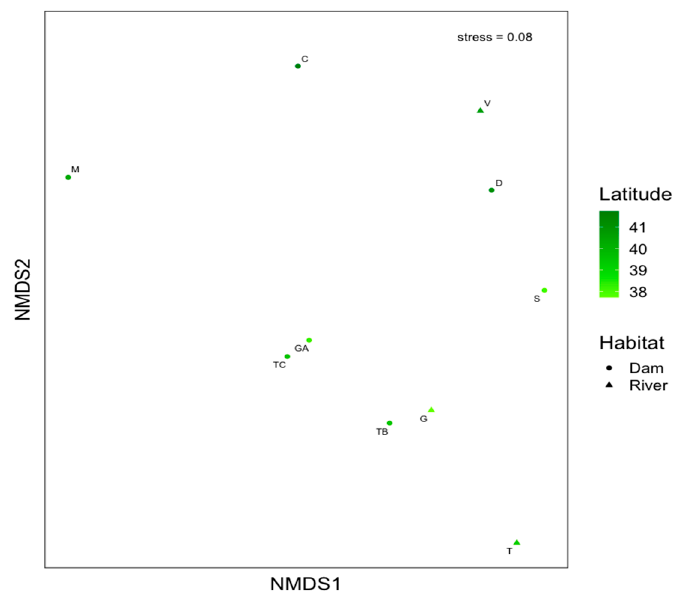
Figure 2. Nonmetric multidimensional scaling (NMDS) ordination of the diet of pikeperch Sander lucioperca populations in Portuguese basins using averaged mean locations (i.e., centroids). Symbols for sites are shaded by latitude from north (dark) to south (lighter).